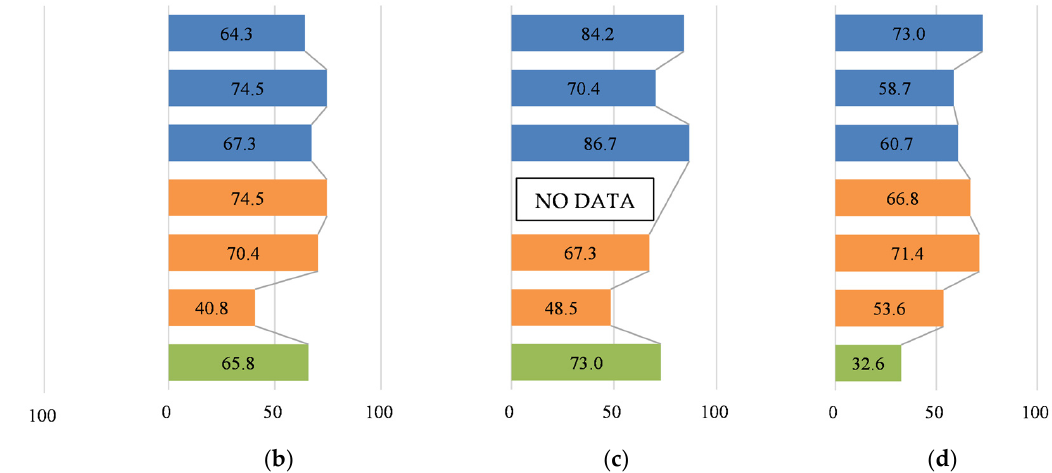
Figure 16. Summer comfort range percentage based on the BESCS for the ( a )total average and in ( b ) class A, ( c ) class B, and ( d ) class C.